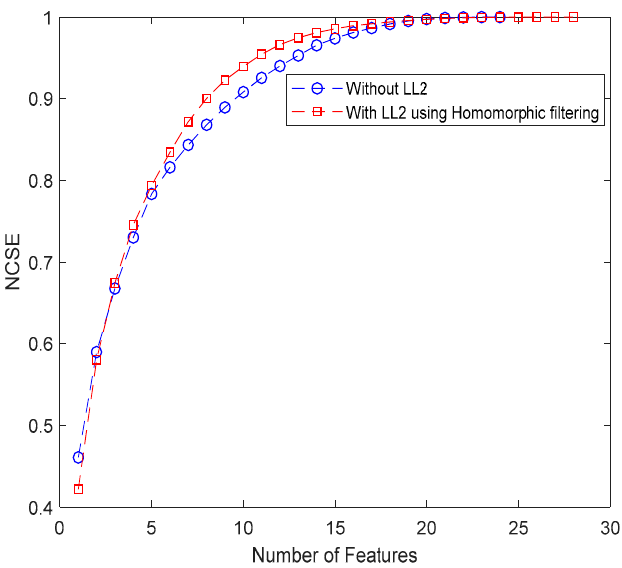
Figure 5. Normalized cumulative summation of eigenvalues of training data for GARCH (1, 1) with and without LL2 (Eight-classes).